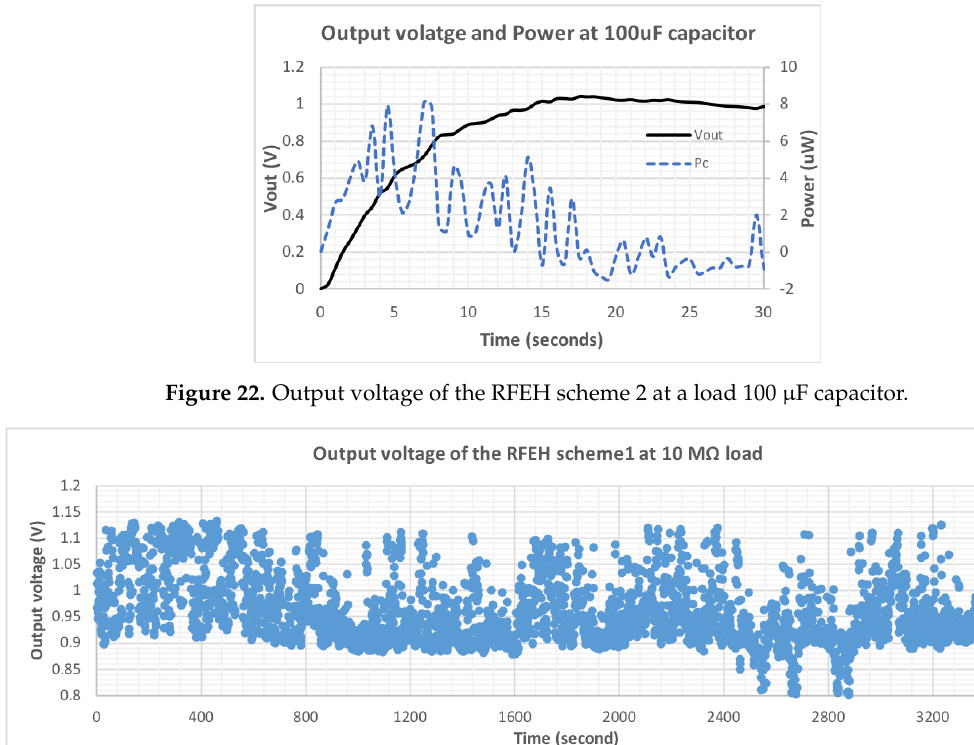
Figure 21. Distribution of input power as measured for 1 h.